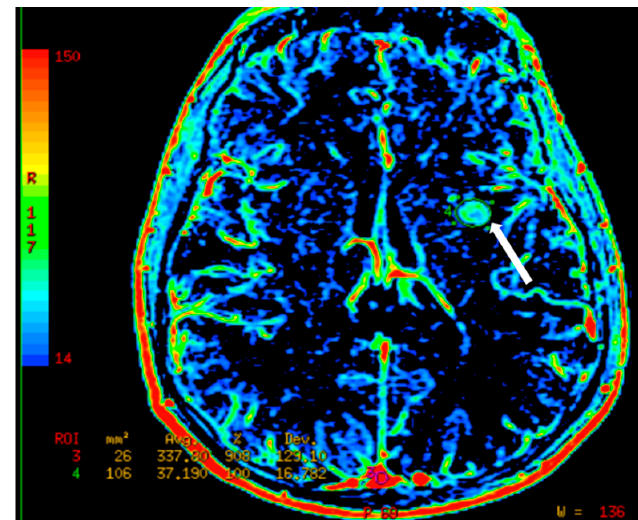
Figure 9. Axial dynamic contrast ‐ enhanced (DCE) MRI of the brain with a relative cerebral cerebral blood volume (rCBV) map, which shows relatively increased flow dynamics in the left basal ganglia lesion (arrow).